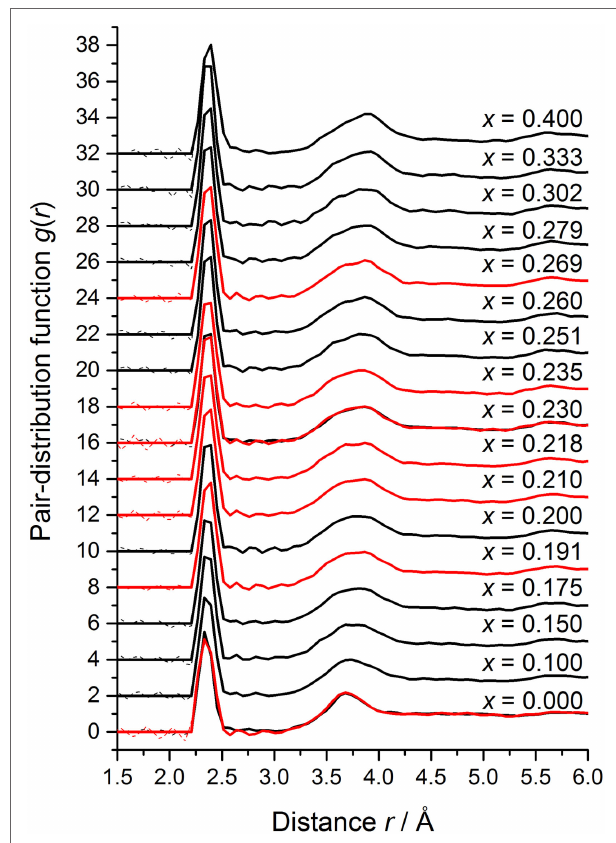
FIGURE 9 | The composition dependence of the measured total pair-distribution function g ( r ) ≃ g NN ( r ) for the Ge x Se 1 (cid:0) x system, as obtained by Fourier transforming the spline fitted S ( q ) functions shown in Figure 6 with q max set at a node in S ( q ) at ≃ 32Å (cid:0) 1 . The GEM and SANDALS data sets are shown by the dark solid (black) and light solid (red) curves, respectively. The Fourier transform artifacts at r values smaller than the distance of closest approach between two atoms are shown by broken curves oscillating about the g ( r → 0) = 0 limit. The curves for x > 0 have been displaced vertically for clarity of presentation.